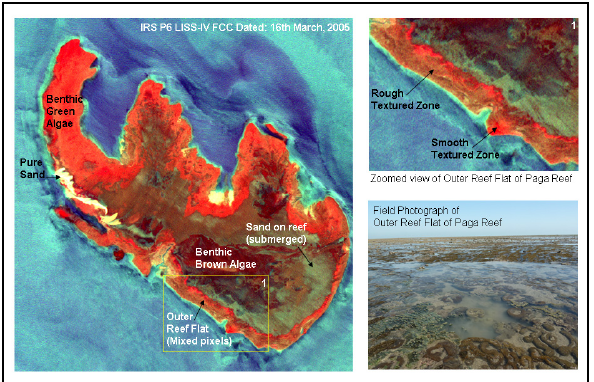
Figure 3. Multi-spectral signatures of selected substrates of